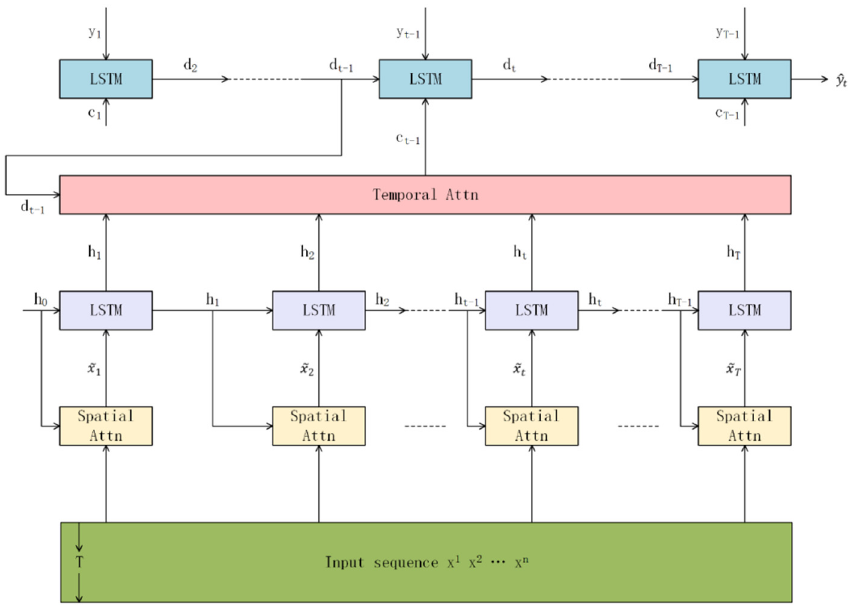
Figure 1. DA-RNN networks architecture.